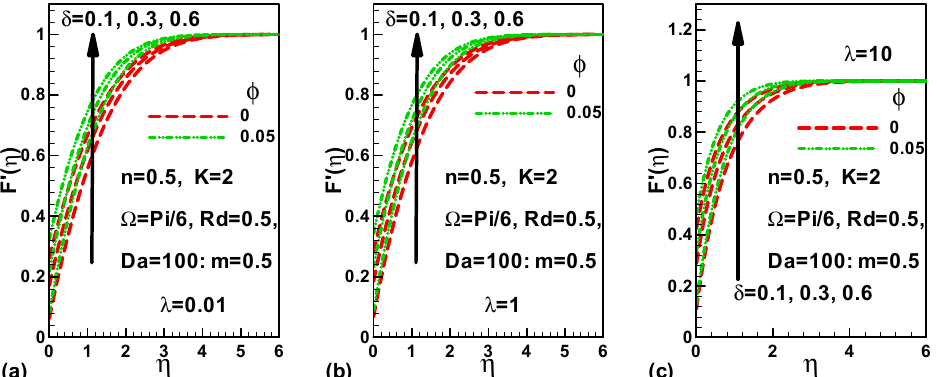
Figure 3. Variation of dimensionless velocity with slip parameter and solid volume fraction of nanoparticles for ( a ) forced convection, ( b ) mixed convection, and ( c ) free convection.